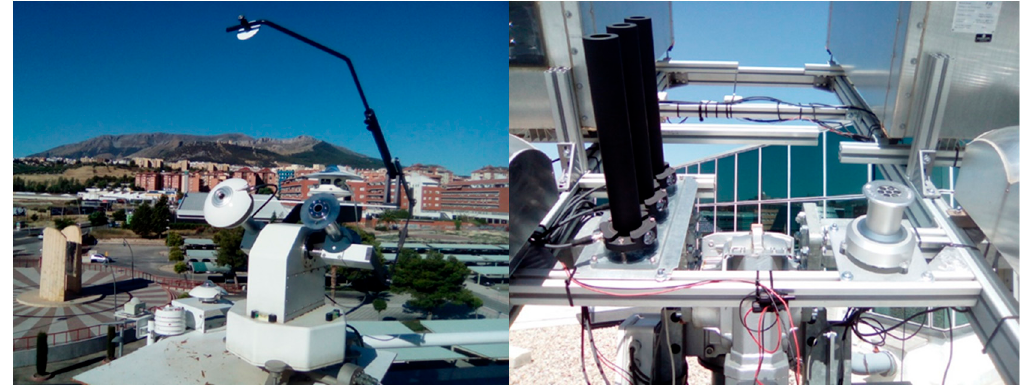
Figure 1. Irradiance ( left ) and spectral ( right ) sensors including component solar cells and the SolarSIM-D2.